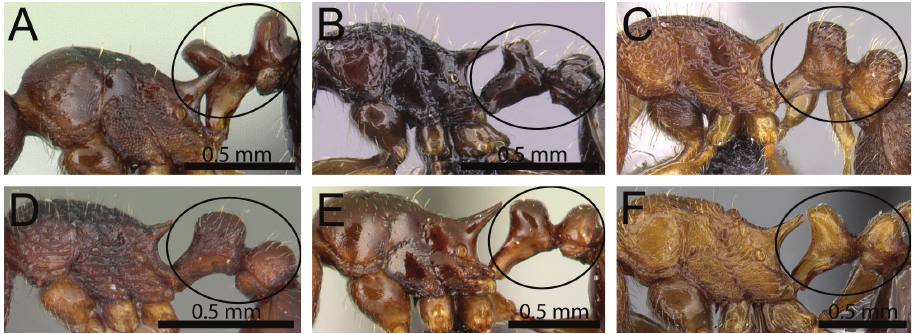
7 Petiolar node and postpetiole strongly squamiform, petiolar node with ante- rior and posterior faces parallel and well developed, straight dorsum; petiole and postpetiole always completely unsculptured, smooth, and shining; stand- ing pilosity scarce or absent on dorsal mesosoma and waist segments, first gastral tergite without standing pilosity (Fig. 7A) ........ T. weitzeckeri group – Character combination never as above; petiole and postpetiole variably shaped, especially postpetiole never squamiform as above (Fig. 7B, C, D, E, 8C, D); if petiole squamiform and postpetiole weakly squamiform, then petiolar dorsum reduced and strongly tapering backwards posteriorly (Fig. 7F) ...................... 8